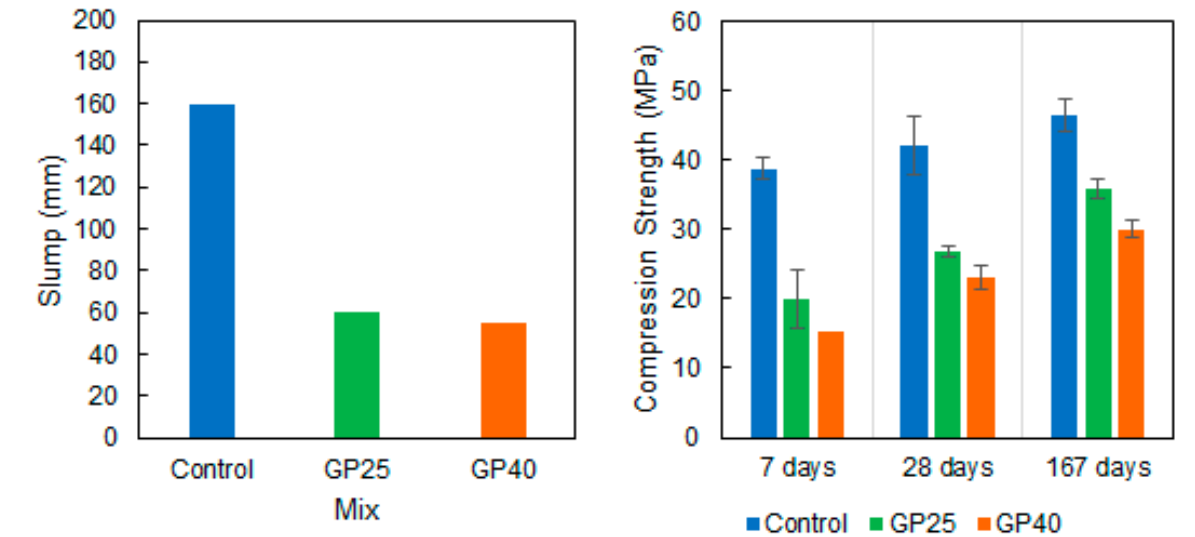
Figure 9. Slump ( left ) and compression strength ( right ) values of the concrete mixes with different replacement rates of cement with GP (averages are bars and standard deviations are whiskers).